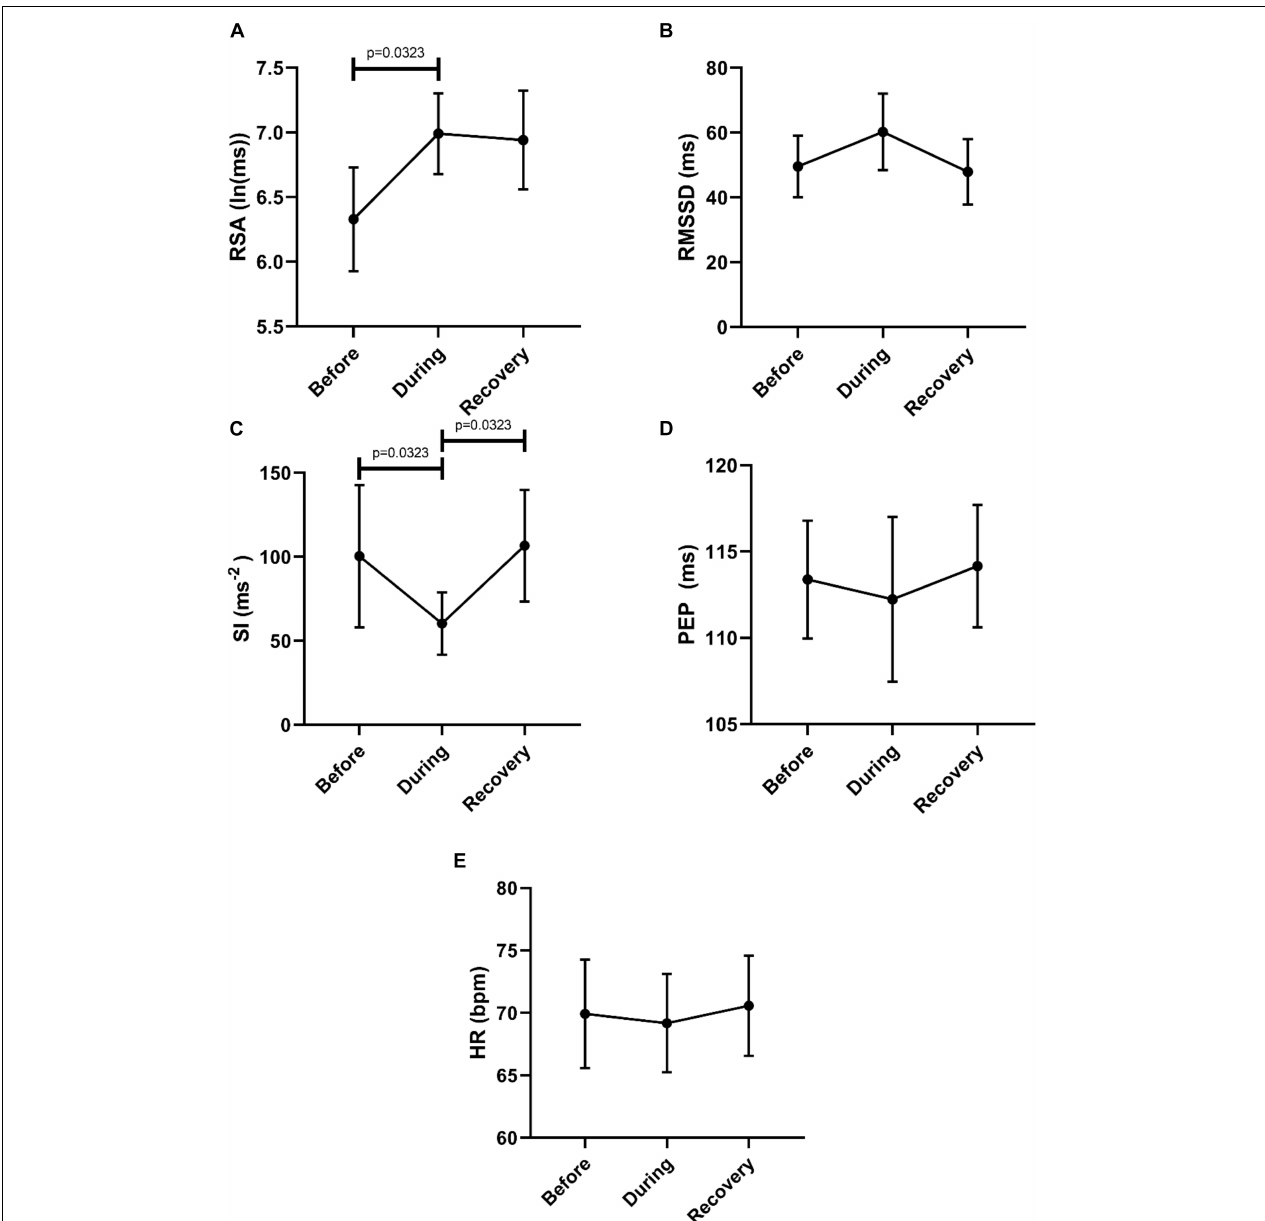
FIGURE 6 | Overall changes in autonomic activity in response to HAPW-SPW’s. Data sets are derived by averaging all 45 motor patterns within 7 subjects, hence n = 7. The following HRV parameters were assessed: RSA (A) , RMSSD (B) , the Baevsky’s Stress Index (SI) (C) , PEP (D) , and heart rate (E) . The Friedman test was applied for assessment of significance followed by Dunn’s multiple comparisons test